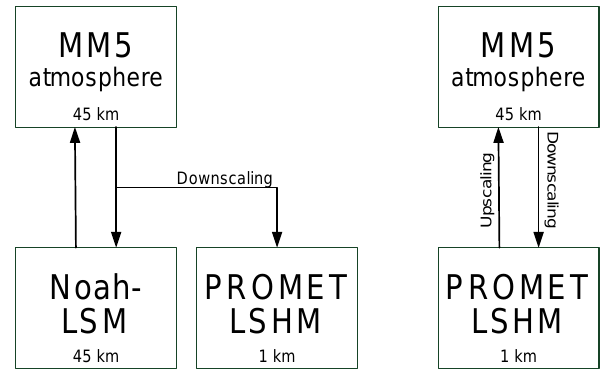
Figure 1: Schematic illustration of applying the original Noah-LSM (left) as land surface representation within MM5, applying a 1-way coupling with the PROMET LSHM (second from left) and 2-way coupling the PROMET LSHM with the MM5 atmosphere (right).